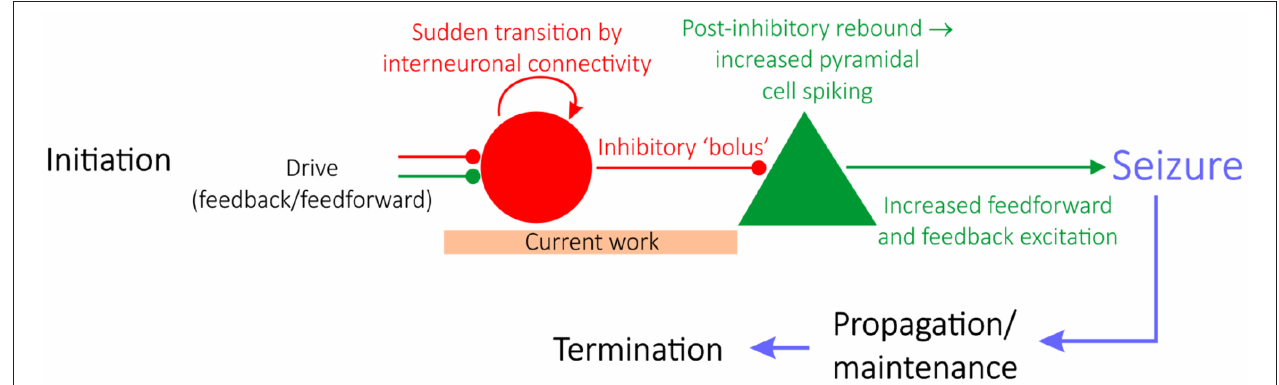
FIGURE 1 | A “GABAergic initiation hypothesis” in the context of the state of epilepsy research. Epilepsy research is divided into studies focusing on seizure initiation (e.g., Miri et al., 2018), propagation (e.g., Trevelyan et al., 2006; Ellender et al., 2014), or termination (e.g., Schindler et al., 2007). Given the focus on interneuronal dynamics prior to seizure, this work sheds light on a “GABAergic initiation hypothesis” of seizure, diagrammed in detail here. The articulation of a potential mechanism explaining the sudden transition of interneurons into synchrony, alongside a justification as to why networks in a seizure state are more vulnerable to this transition, should be identified in order for this overall hypothesis of seizure initiation to be